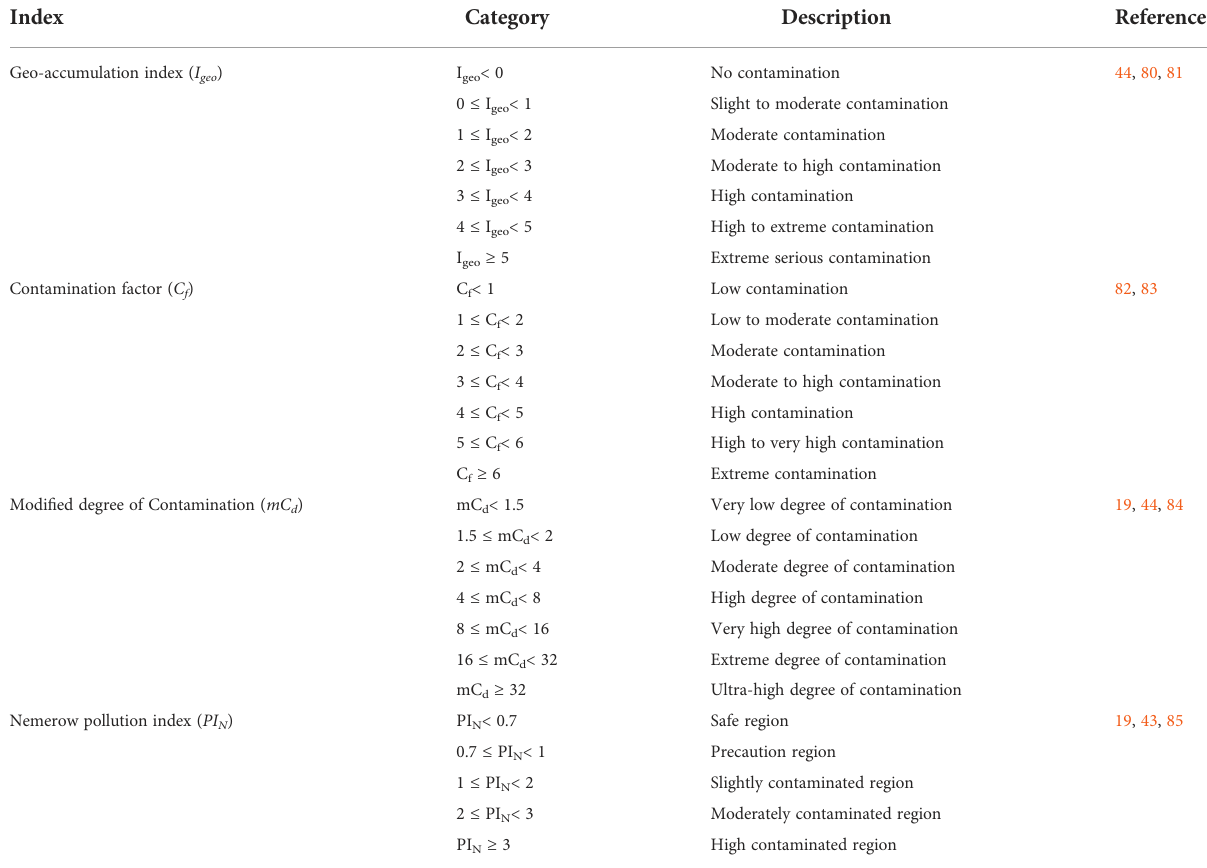
TABLE 1 Contamination indices based on the classi fi cation of